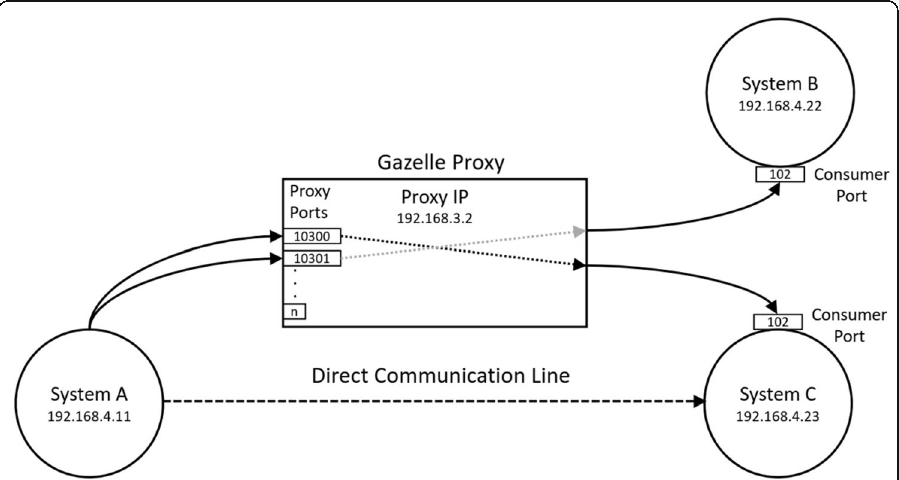
Fig. 3 The alternative communication between systems via Gazelle proxy service. The port numbers are assigned to the systems prior to start the testing session. Subsequently, the transferred messages are captured and undergo further